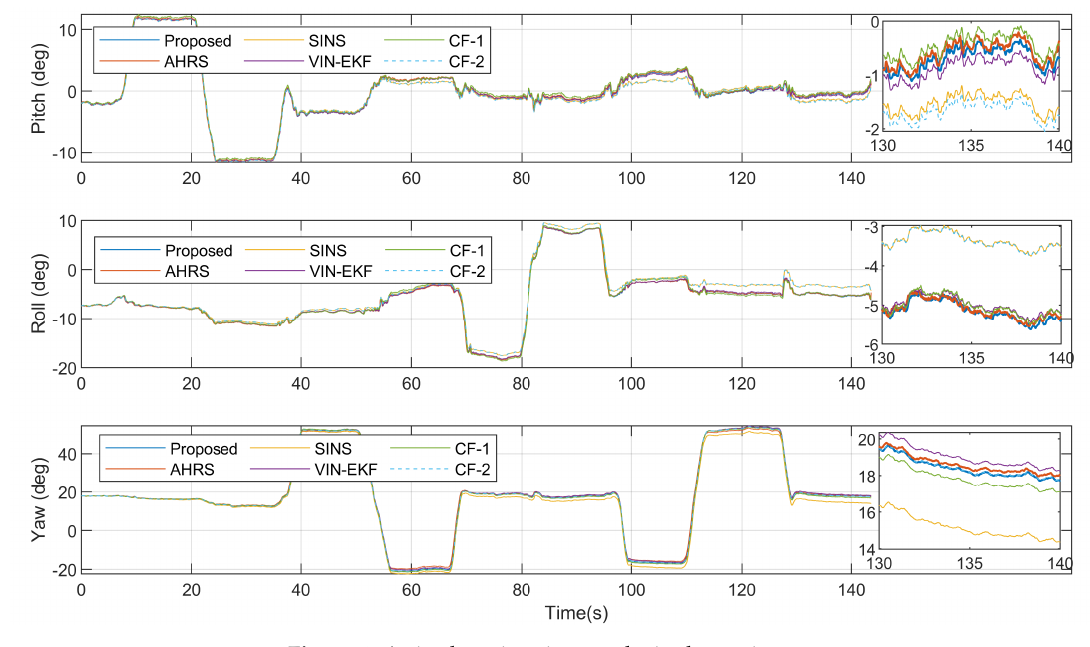
Figure 4. Attitude estimation results in the static case.